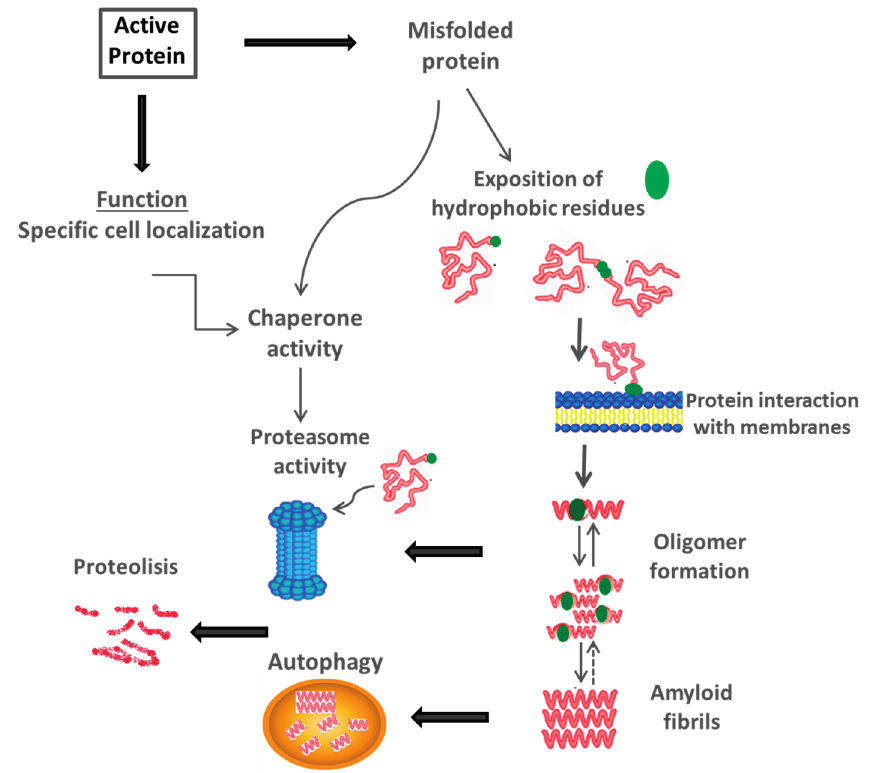
Figure 2. Cell mechanisms that control protein structure. Alterations in protein